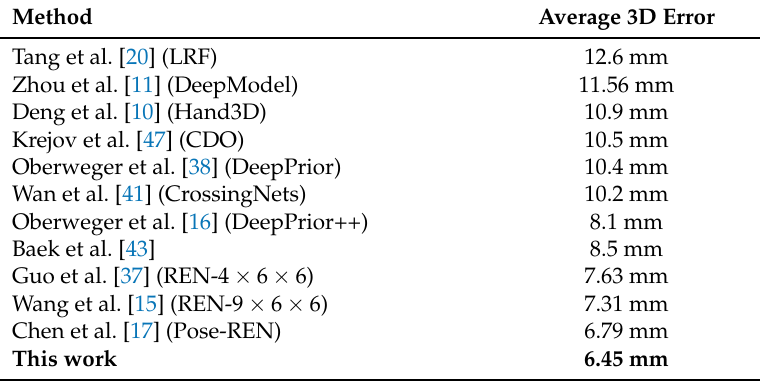
Table 3. On the ICVL dataset [20], we compare the proposed approach to the state of the art. It proves that our method has better results by the evaluation metric of the average 3D joint error in the table below.